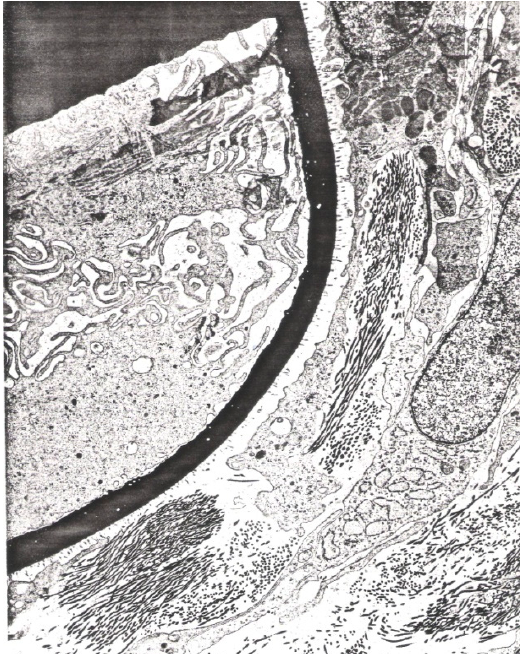
Figure 2. Transmission electron graph (×80,000) of the eggshell and collagen fibres. The eggshell is surrounded by many collagen fibres with part of an eosinophile leukocyte with numerous granules in view, top right.